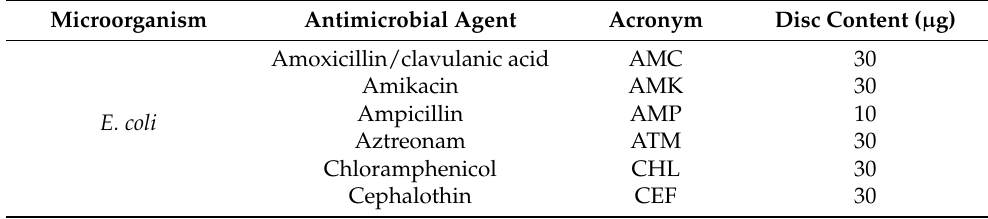
Table 1. Antimicrobial agents used to evaluate the resistance profile of E. coli and Enterococcus spp. isolated from farming water, edible portion, hemolymph, and superficial biofilm